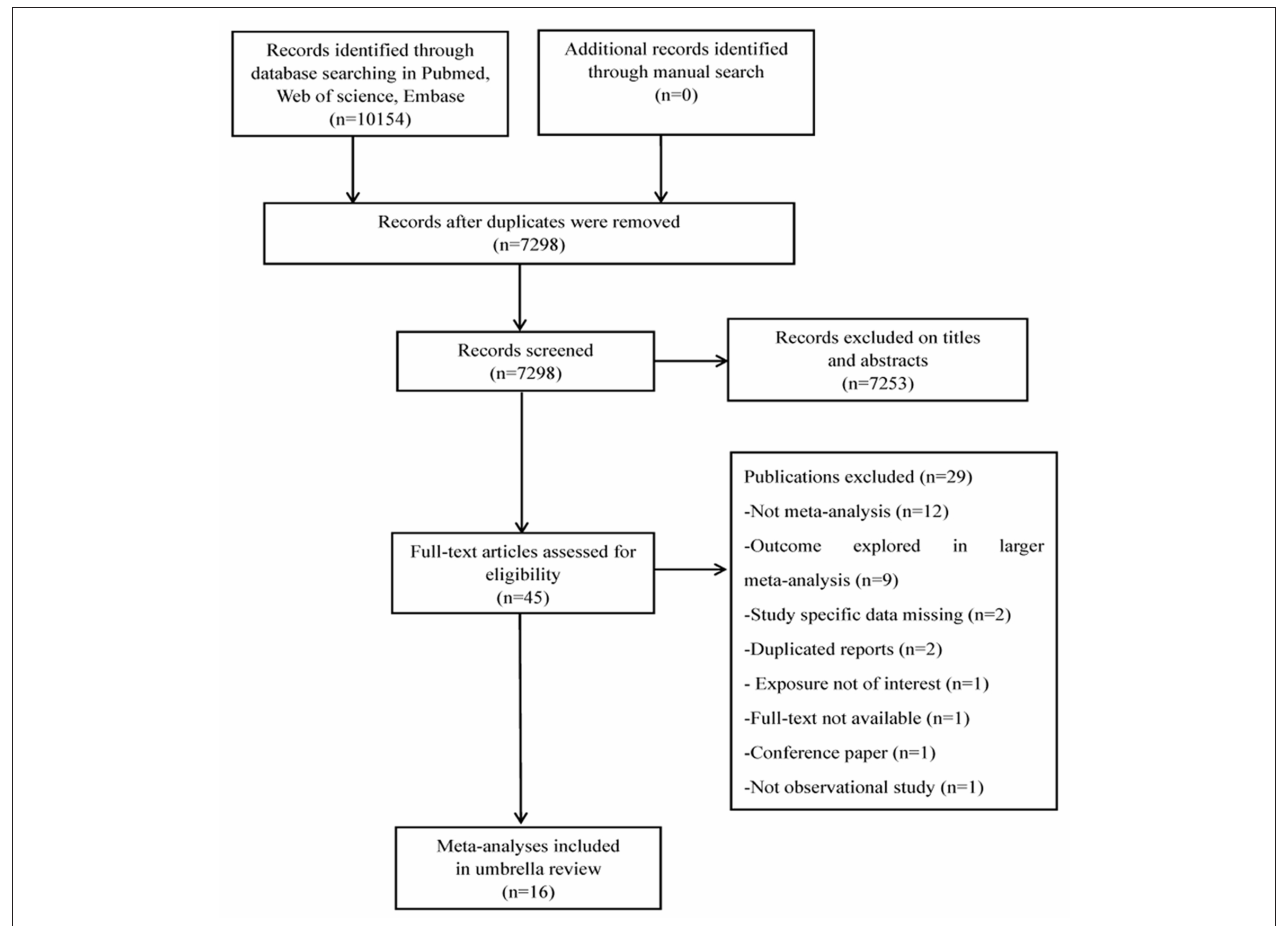
FIGURE 1 | Flowchart of selection of studies for inclusion in umbrella review on DII and health